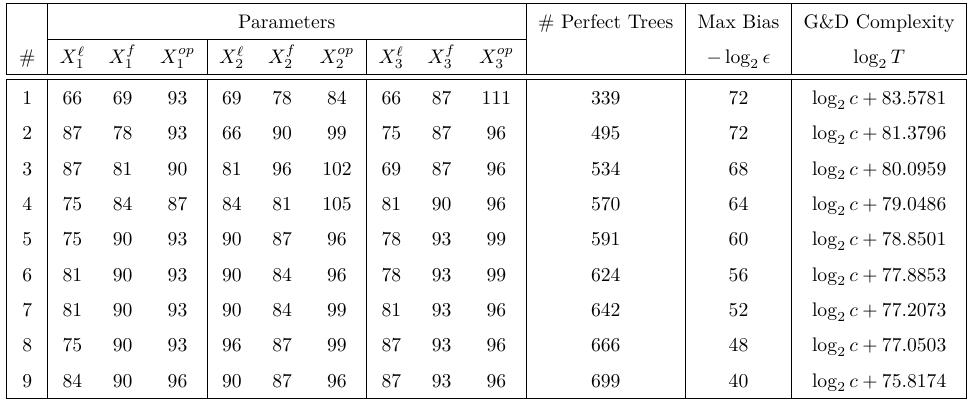
Table 1: List of configurations and associated security parameters. (cid:15) represents maximum linear bias. T is the complexity of guess-and-determine attack. c represents an additional cost required to do Gaussian elimination to solve a set of linear equations to recover the internal state. The first row represents the parameters for the original Trivium